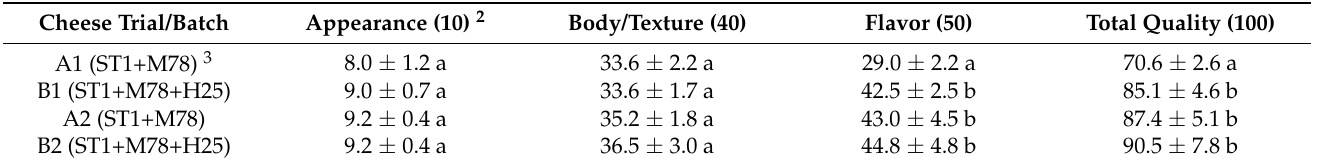
Table 6. Organoleptic characteristics of traditional Galotyri PDO cheese products after two weeks of ripening 1